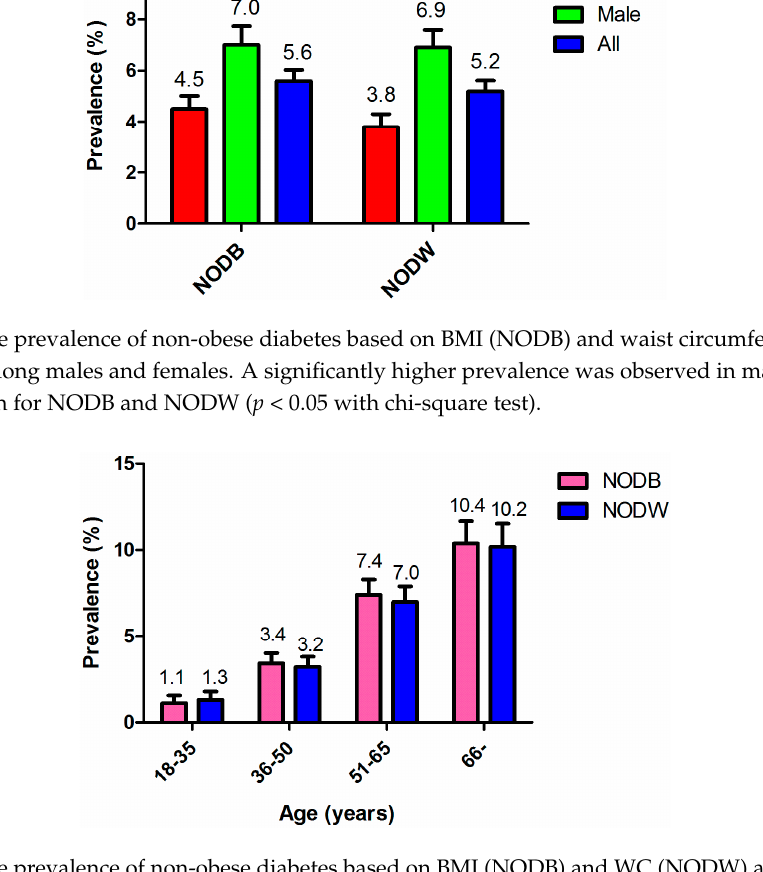
Table 1. Characteristics of newly diagnosed and non-obese diabetes mellitus in Guangxi. Characteristics